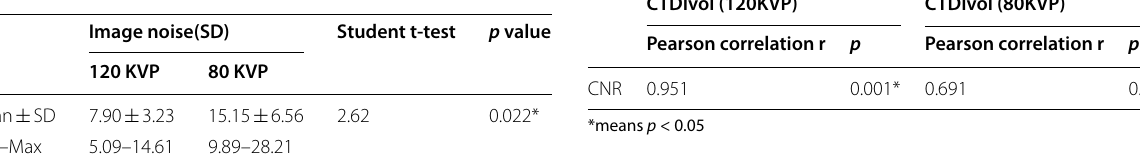
Table 4 Comparison of image noise (SD) between 120 and 80 KVP